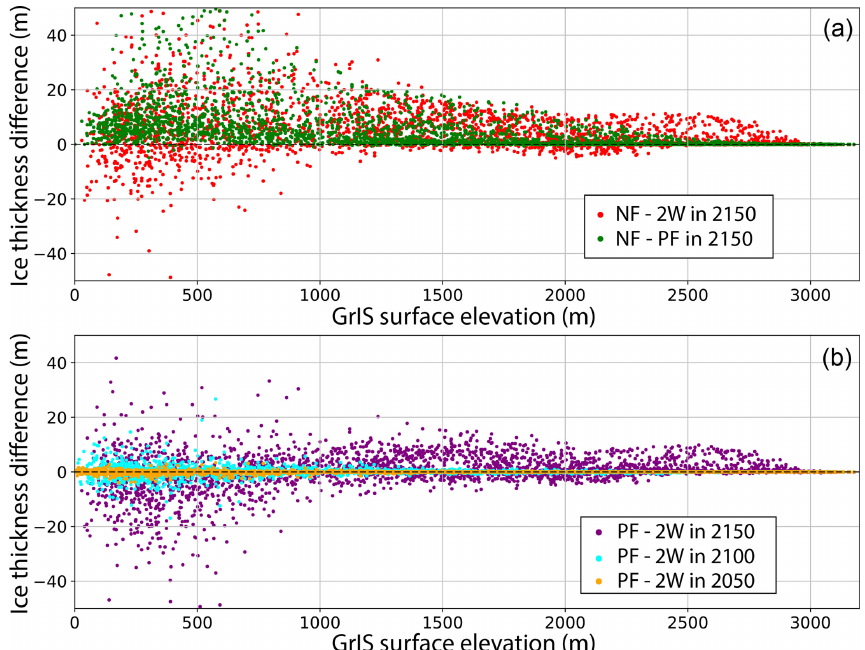
Figure 11. Ice thickness difference (m) as a function of the GrIS surface elevation (m) for the three coupling experiments. In (a) the red and green dots represent the NF–2W and the NF–PF differences in 2150; (b) ice thickness difference (PF–2W) in the 2050 (purple dots), 2100 (light blue dots) and 2150 (orange dots) mean